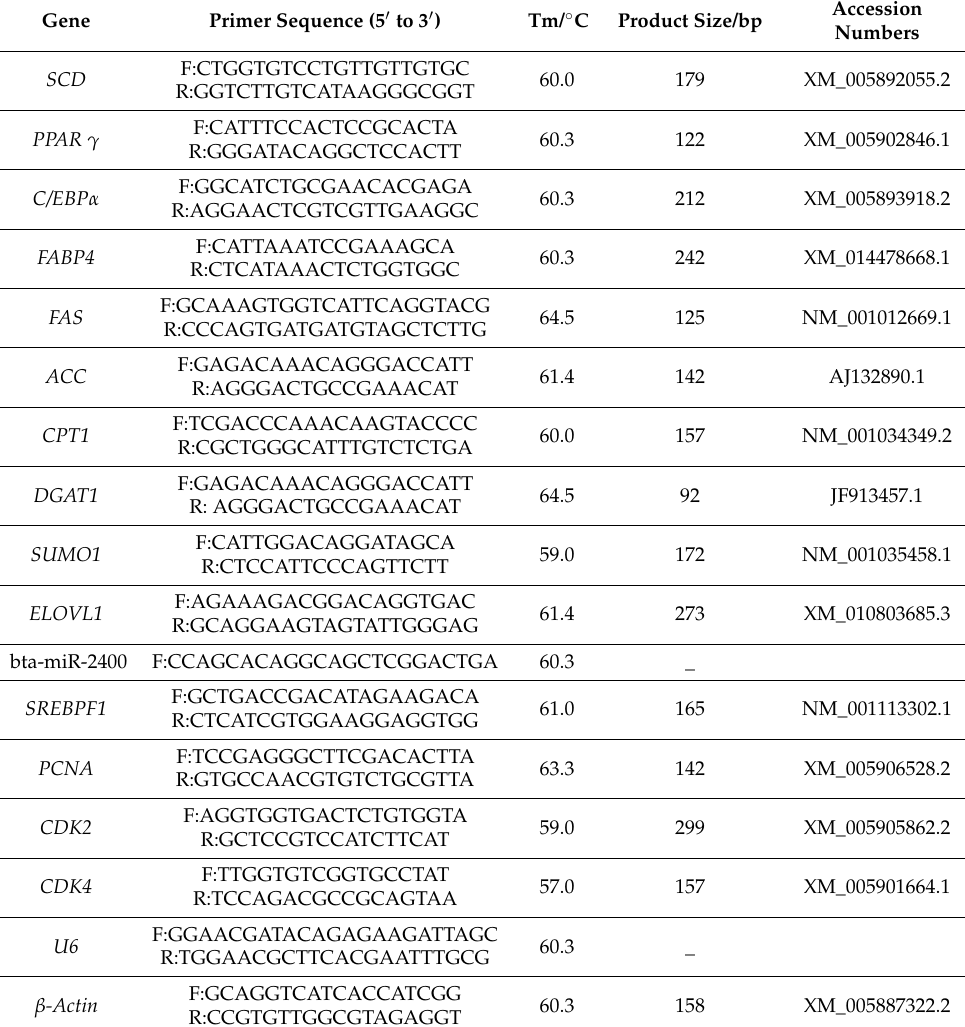
Table 1. Sequence specific primers were used in this study. F: forward, R: reverse. β -Actin and U6 were used as endogenous control genes for mRNA and